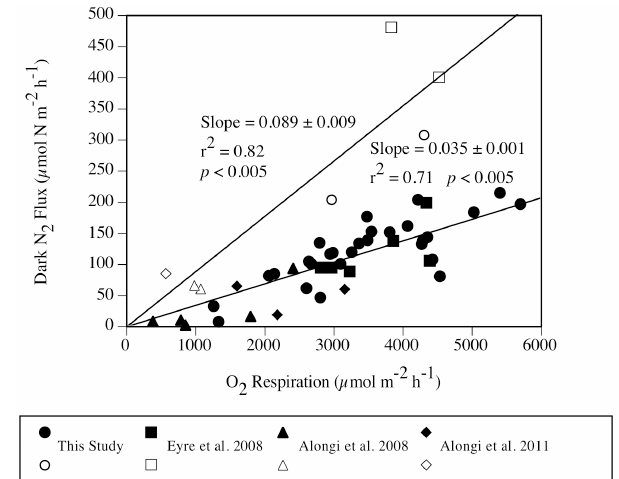
Fig. 6. Dark N 2 effluxes versus benthic respiration for carbonate sands from this study (individual chambers), Eyre et al. (2008) (in- dividual chambers) and Alongi et al. (2008, 2011). See Table 4 for sites used from Alongi et al. (2008, 2011). Open symbols are out- liers that fall above the upper 95% confidence interval of the regres- sions of each of the 3 data sets above (see